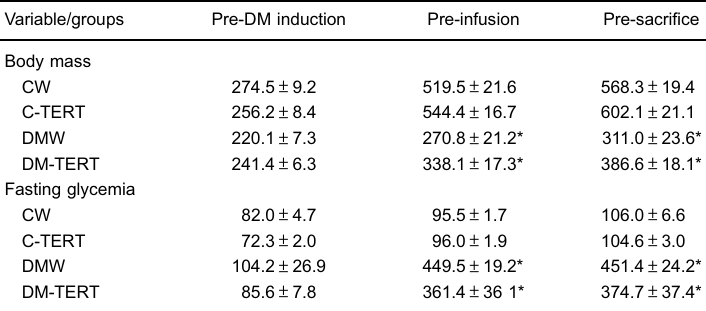
Table 1. Body mass (g) and fasting glycemia (mg/dL) pre-diabetes mellitus (DM) induction, pre-infusion of mesenchymal stem cells (MSCs), and pre-sacri fi ce of animals.